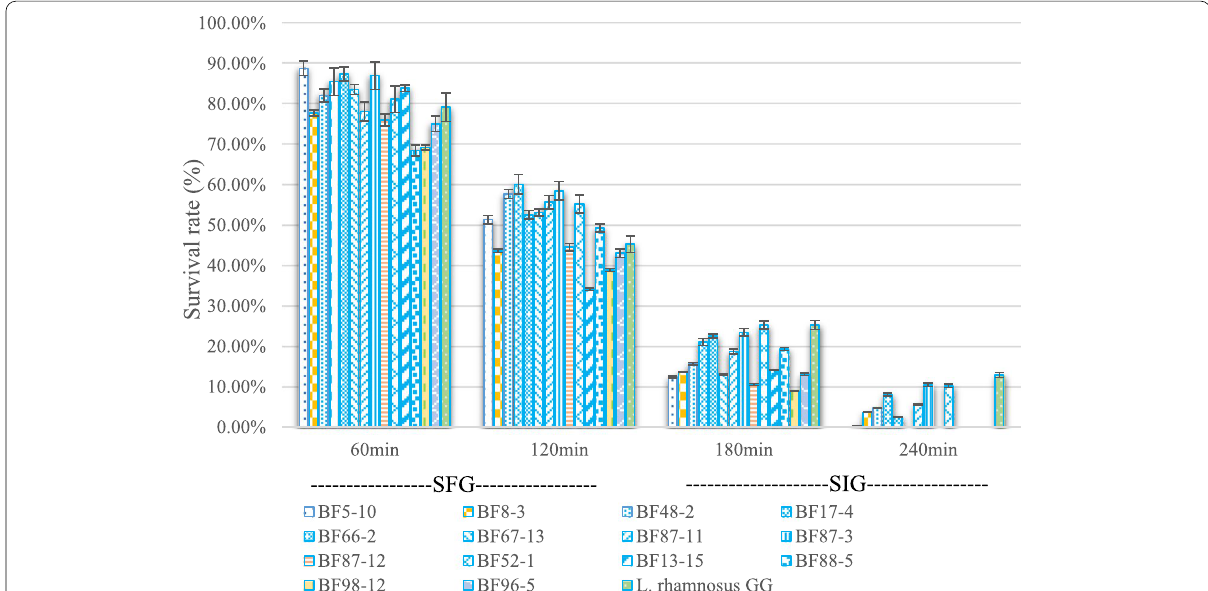
Fig. 2 Survival rate(%)of the Bifidobacterium strains after sequential cultivation in simulated gastric and intestinal fluid. (Error bars indicate standard deviation from three independent